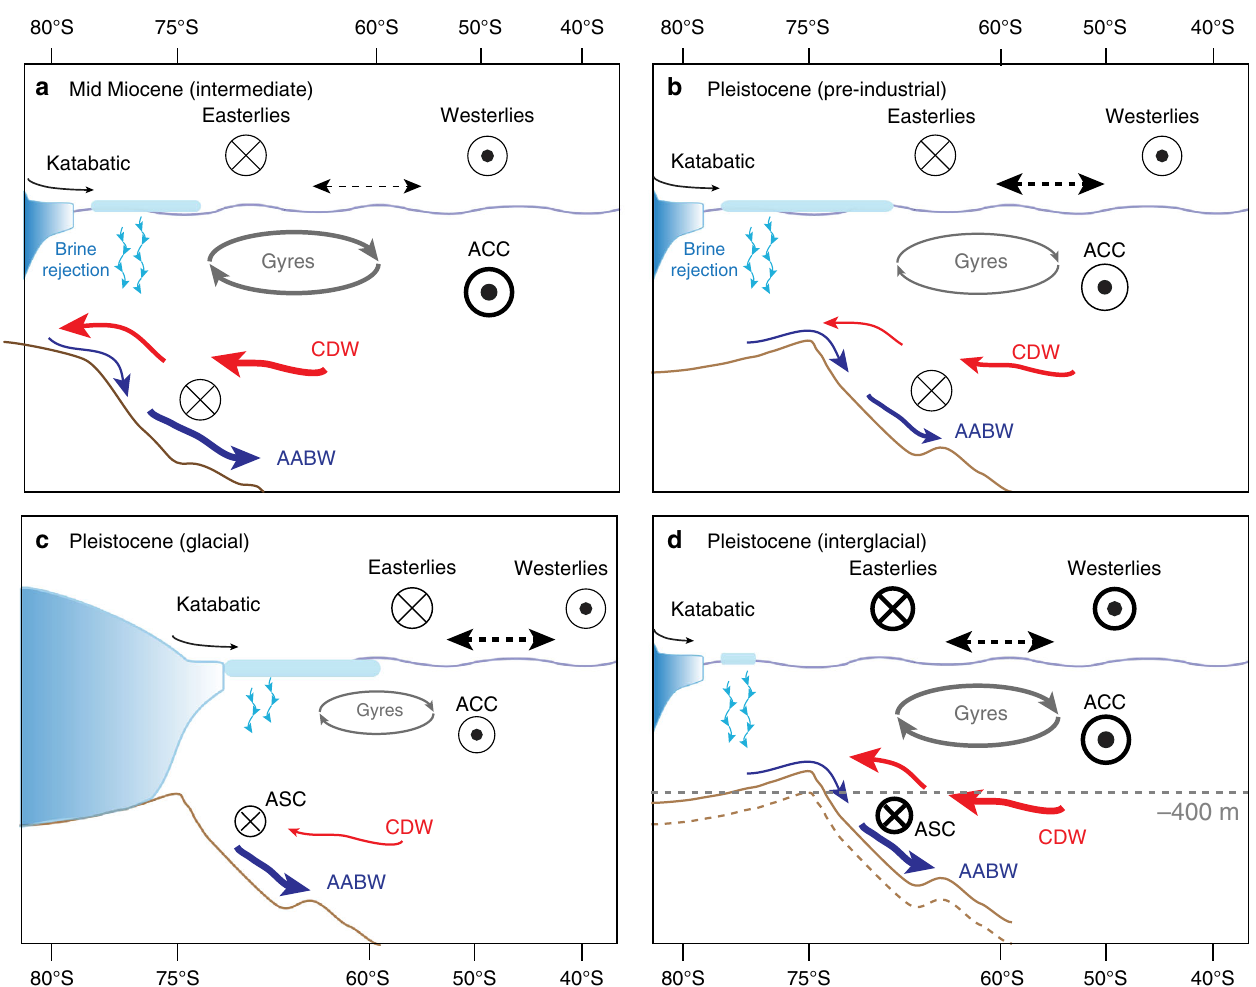
Fig. 4 Schematics of bathymetric control on open-ocean circulation. Impact of long-term continental shelf expansion on the Southern Ocean high-latitude circulation in the Weddell Sea during the mid-Miocene a , during the late-Pleistocene b , and under modern-like climate conditions. During mid-Miocene ( a ), high-latitude ocean circulation is shifted southward due to the smaller continental shelf break 63 compared with the modern one ( b ). Westerly winds are almost aligned with ACC, which strengthens the Gyre circulation and ampli fi es the in fl ow of CDW and out fl ow of AABW 89 across the shelf break, also favored by stronger Easterly winds. At glacial/interglacial timescale, the incursions of CDW on the continental shelf are controlled by the depth and morphology of the continental slope and break 97,117 . During glacial periods c , with low atmospheric CO 2 (< 200 p.p.m.), the AIS expands and the Westerly winds shift northward. Ice-sheet advance on the continental shelf inhibits oceanic circulation, which limits the incursions of CDW 118 . During ice-sheet retreat from the continental shelf edge, shallow-shelf ocean circulation is restored. Model simulations of super interglacials suggest that Westerly and Easterly winds are strengthened and are shifted polewards compared to their modern position d . This enhances incursions of CDW on the continental shelf, increasing the heat supply to the AIS grounding line, and promoting the formation and export of relatively fresh AABW 94 . However, depending on the depth of the continental shelf break and the strength of the Easterly winds modulated by atmospheric teleconnections, CDW may or may not intrude on the continental shelf, despite warm